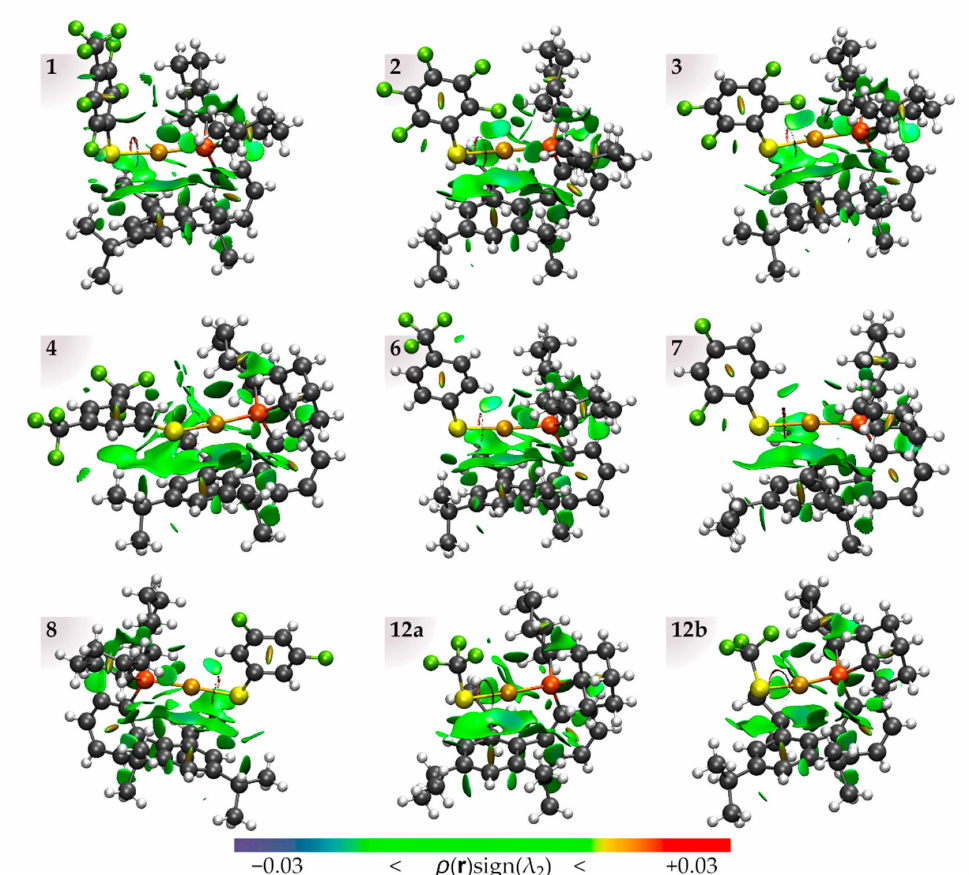
Figure 2. NCI-index isosurfaces revealing the intramolecular non-covalent interactions of compounds 1 – 4 , 6 – 8 , and 12 . Due to the important differences among the two conformers of 12 , both molecular arrangements were analyzed and labeled as 12a and 12b . The color code for understanding the NCI index plots is red for repulsive interactions, blue for an attractive interaction, and green for weak attractive interactions